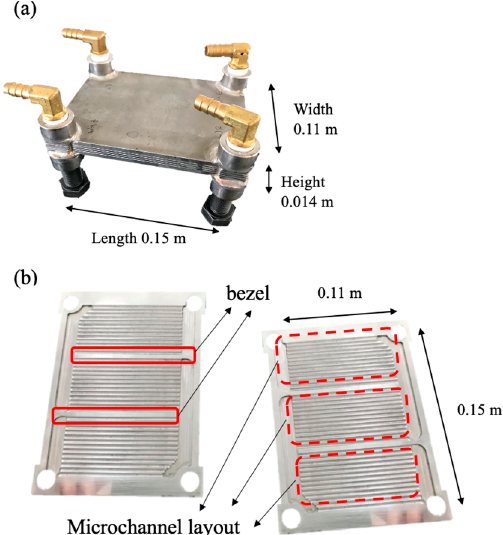
Figure 1. ( a ) The design of the PCHE; ( b ) hot fluid flow plate and cold fluid flow plate in the PCHE.